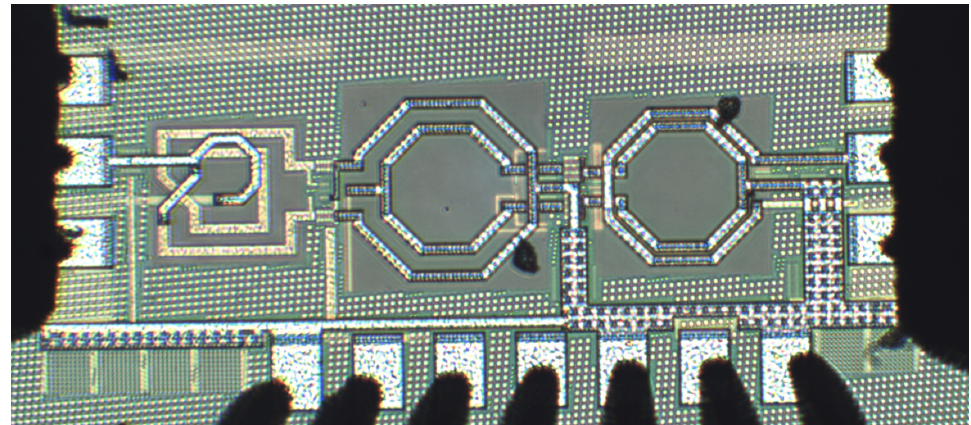
Figure 14. Photograph of the fabricated X-band PA.